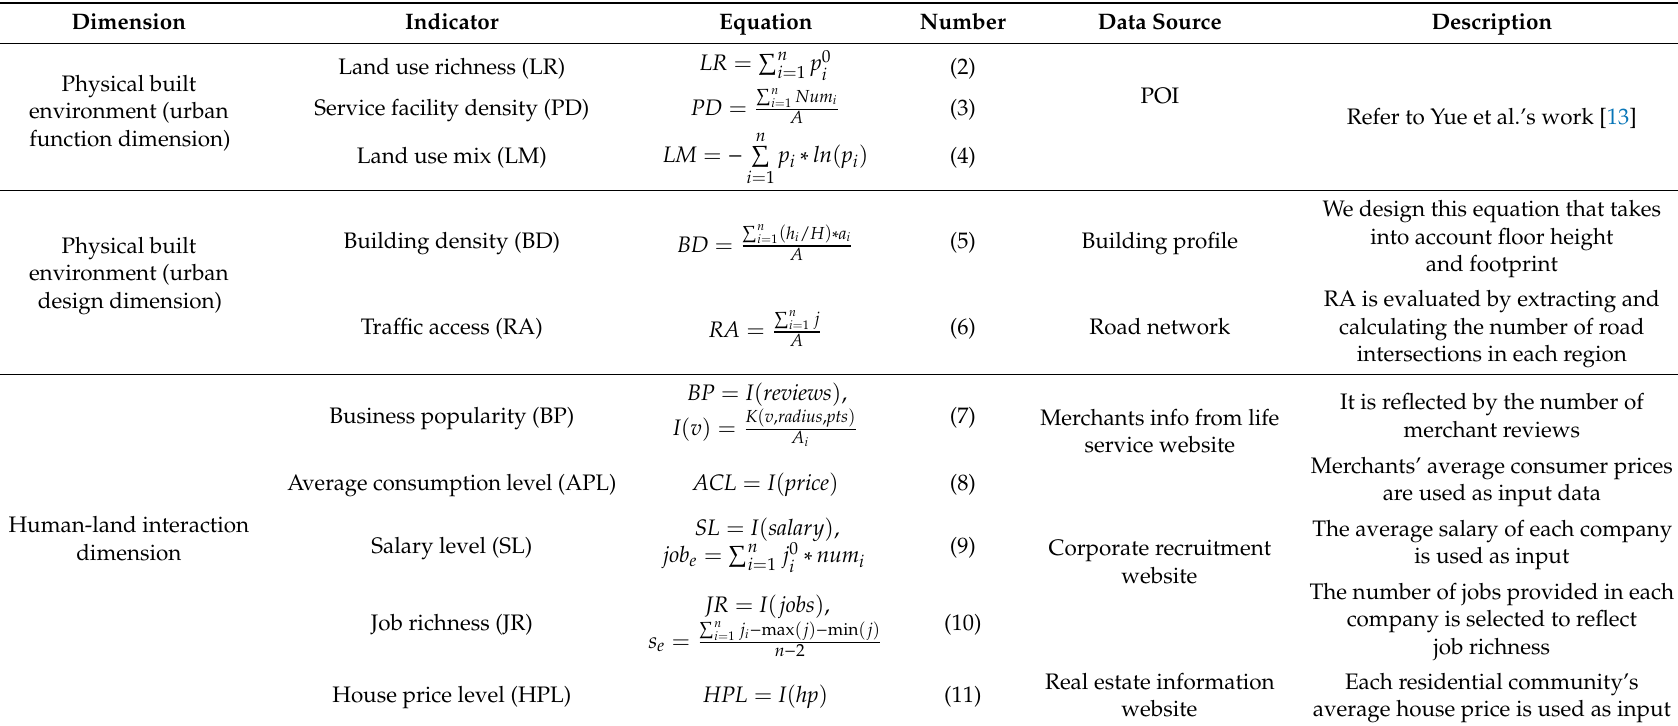
Table 3. Quantification calculation method for urban vitality impact factors designed in our